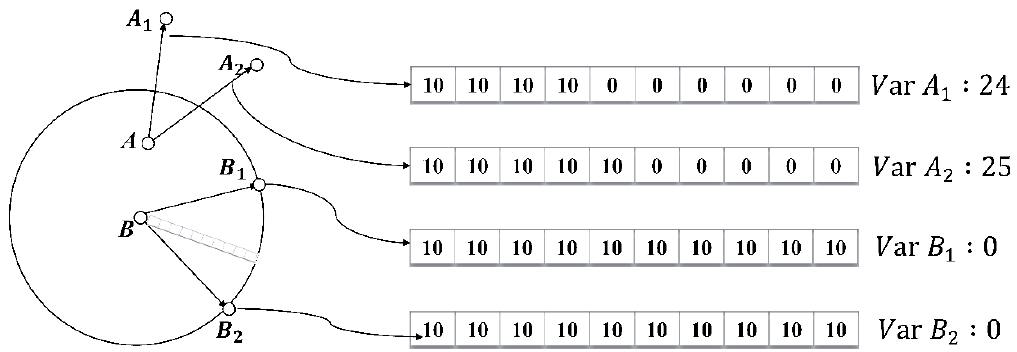
Figure 8. Pixel sets for point A and point B. Variance value of point A 1 is 24, A 2 is 25. Variance value of point A is calculated by the average 24 and 25, which is 24.5.